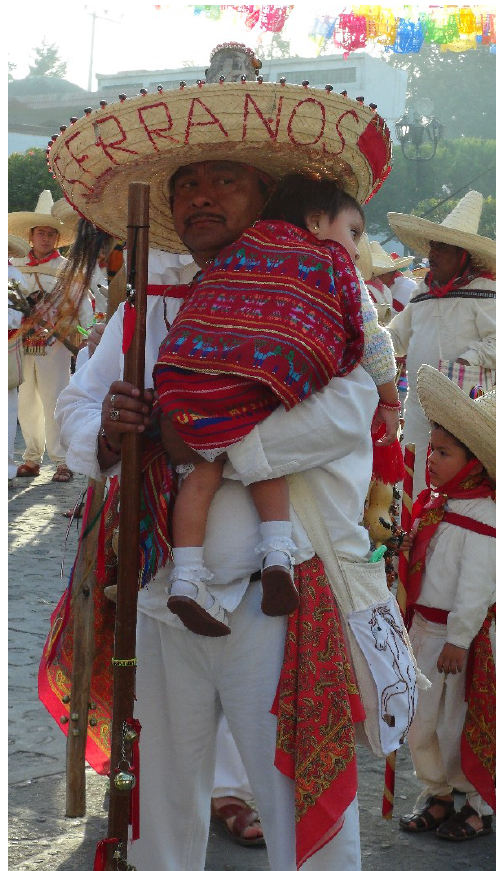
Figure 4 Serranos dancer with daughter in arms during the celebration of the feast of Saint Sebastian, 2018. Tepetlaoxtoc de Hidalgo, Tepetlaoxtoc, State of Mexico. Copyright: Manuel Moreno